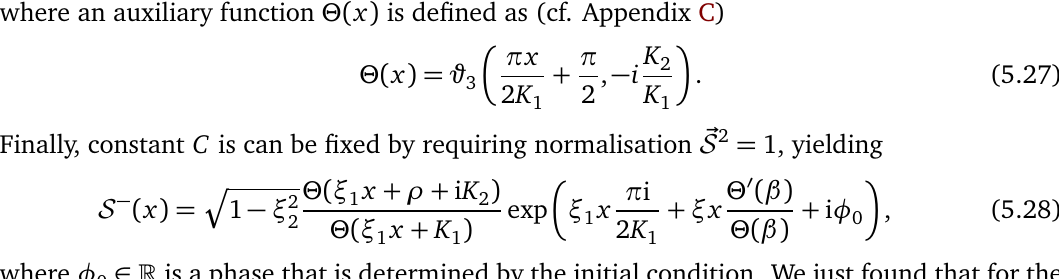
Figure 4: Spin-field components of a typical bion solution, depicted for anisotropy parameter δ = 1 and branch points ξ S z ( x ) , S x ( x ) = Re S − ( x ) , and S y ( x ) = − Im S − ( x ) are shown by blue, yellow